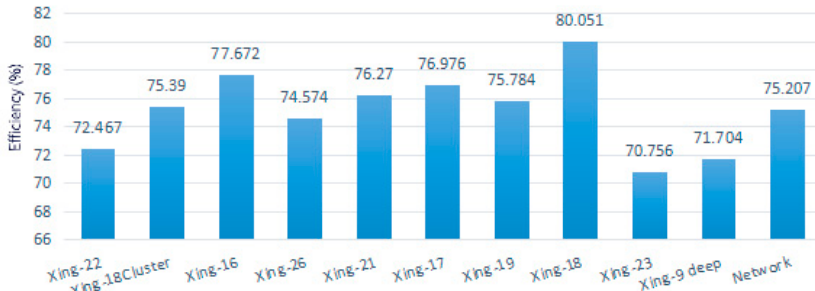
Figure 6. Pipe network efficiency of each station area.